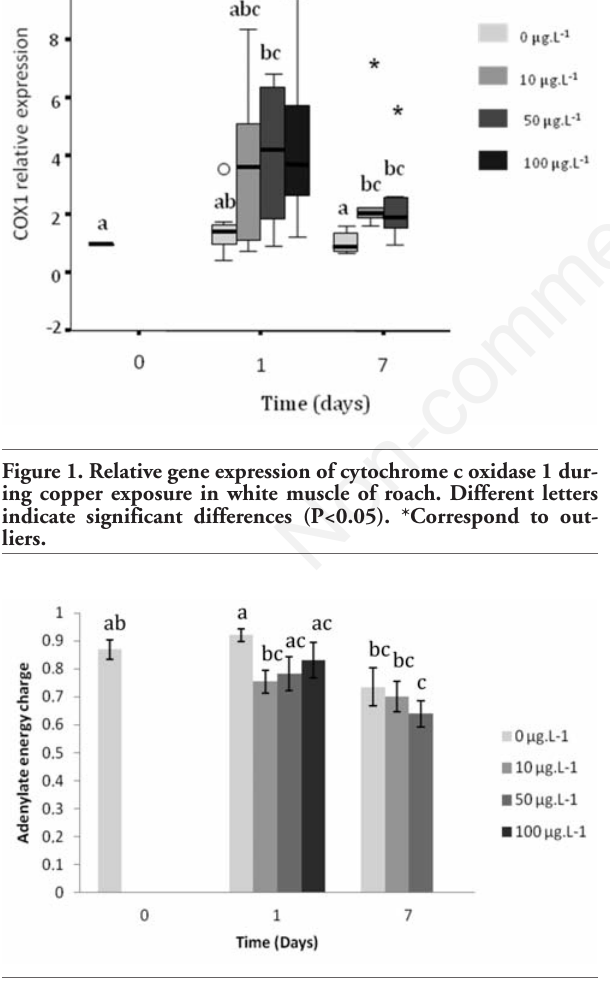
Figure 3. Adenylate energy charge in white muscle of roach exposed to copper. Different letters indicate significant differ- ences (P<0.05).